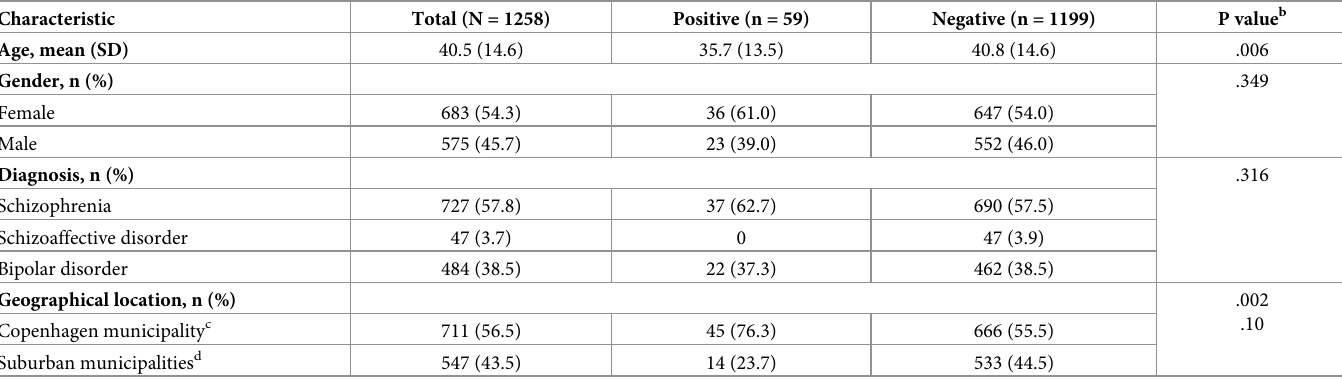
Table 1. Baseline characteristics of study population according to SARS-CoV-2 serology a . Characteristic